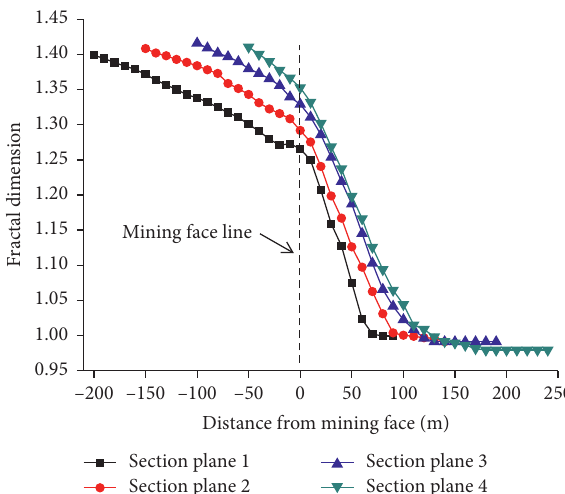
Figure 10: Evolution of the fractal dimension of the fractures in the overburden strata during mining.